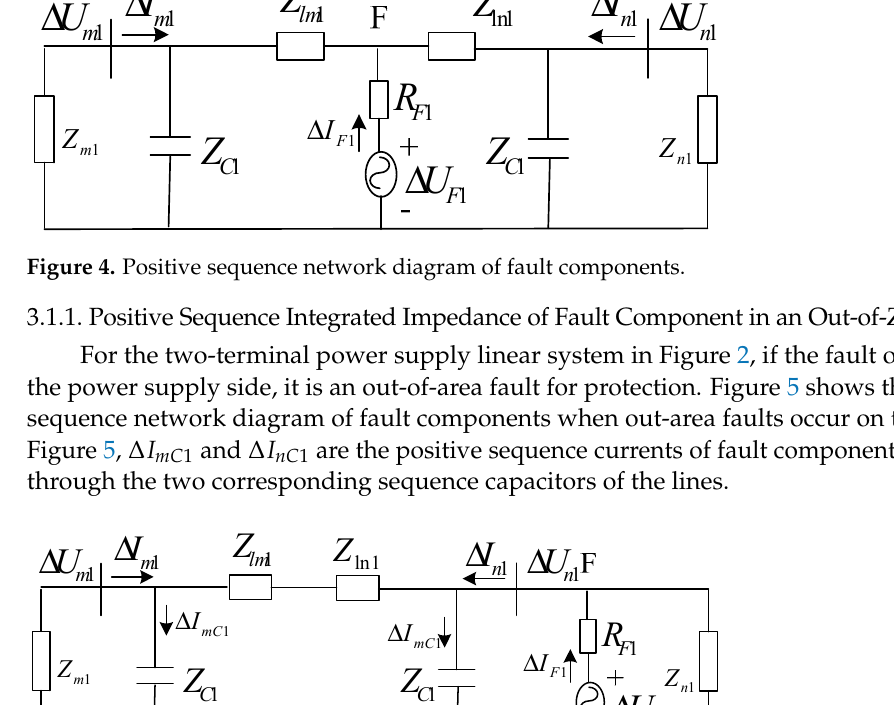
Figure 4. Positive sequence network diagram of fault components.